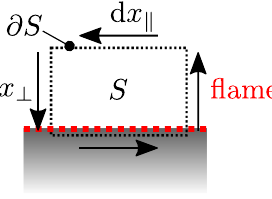
Figure 5. Illustration of the line integral of Equation (40) along a path ∂ S enclosing a surface S .